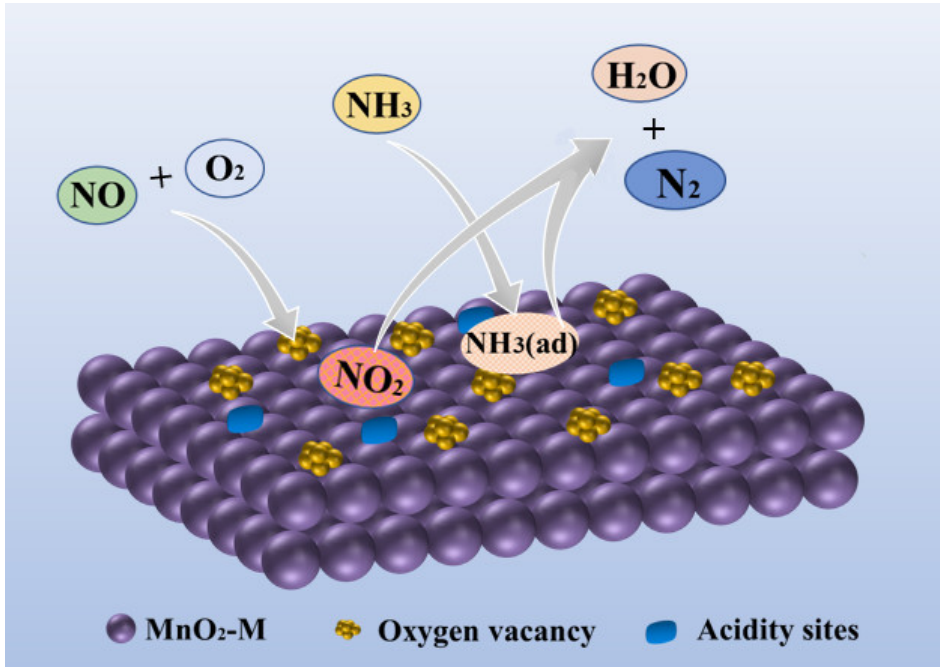
12 of 17 Figure 11. In situ DRIFTS spectra of adsorption of NO + O 2 + NH 3 at a different temperature over MnO 2 -M ( a ) and MnO 2 ( b ). The above results suggest that the adsorption of NH 3 is dominated under the SCR reaction conditions for the two catalysts. The possible reaction mechanism over MnO 2